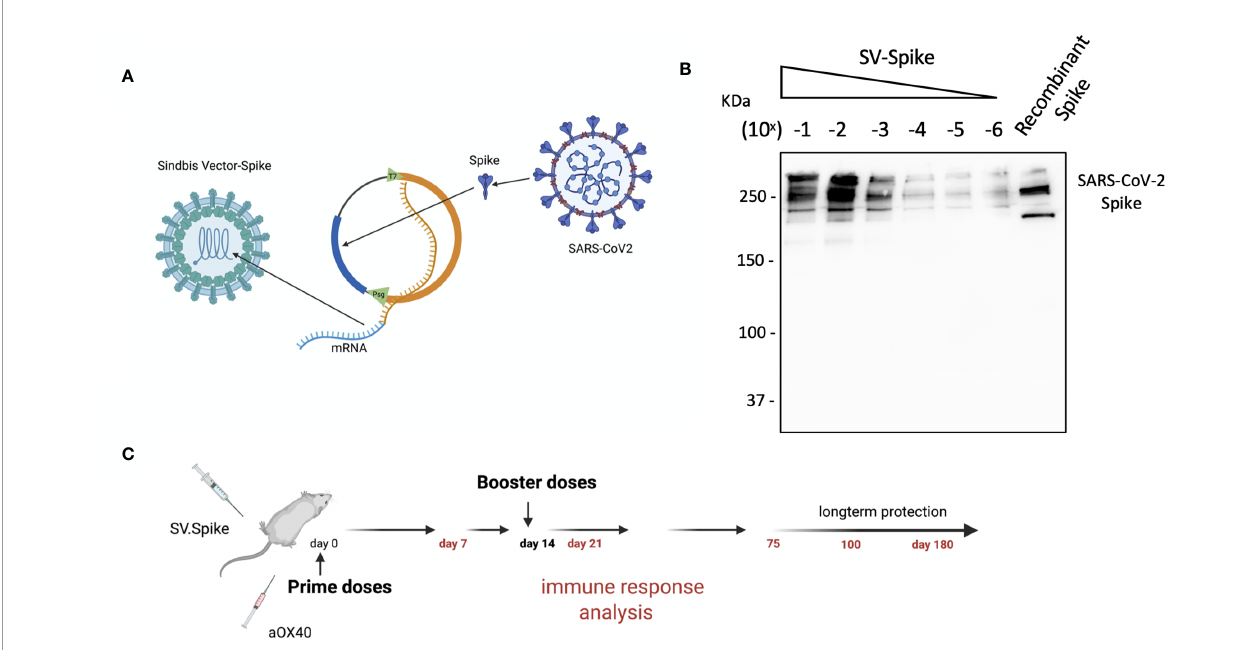
FIGURE 1 | Characterization of Sindbis vector carrying the SARS-CoV-2 spike. (A) Schema of SARS-CoV-2 spike gene cloned into Sindbis vector system. (B) Western Blot of SARS-CoV-2 spike produced from the Sindbis vector. Lanes shown are titration of the vector, and recombinant spike control produced in HEK cells. (C) Schematic of vaccination. C57BL/6 mice were immunized with 1× 0.5 ml SV.Spike/and or a OX40 antibody (250 m g/dose) on day 0. A boost injection of SV.Spike/and or a OX40 were once given on day 14. On days 7, 14 and 21, 75, and 100, blood was taken to determine Sars-Cov-2 spike speci fi c antibodies by ELISA. Spleens were excised and a single cell suspension was stained and analyzed by fl ow cytometry. T cells were isolated and were used for ELISPOT assay and Seahorse. As control, naïve C57BL/6J mice were